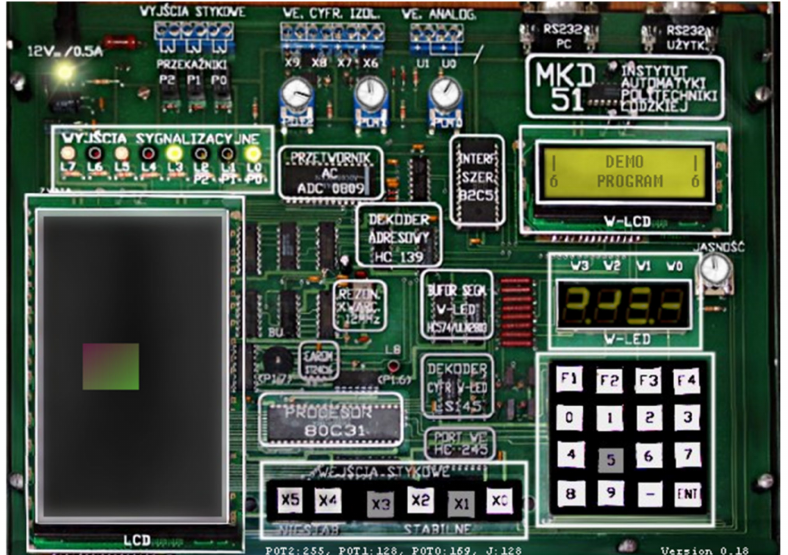
Figure 2. The MKD-51 SIM running demo